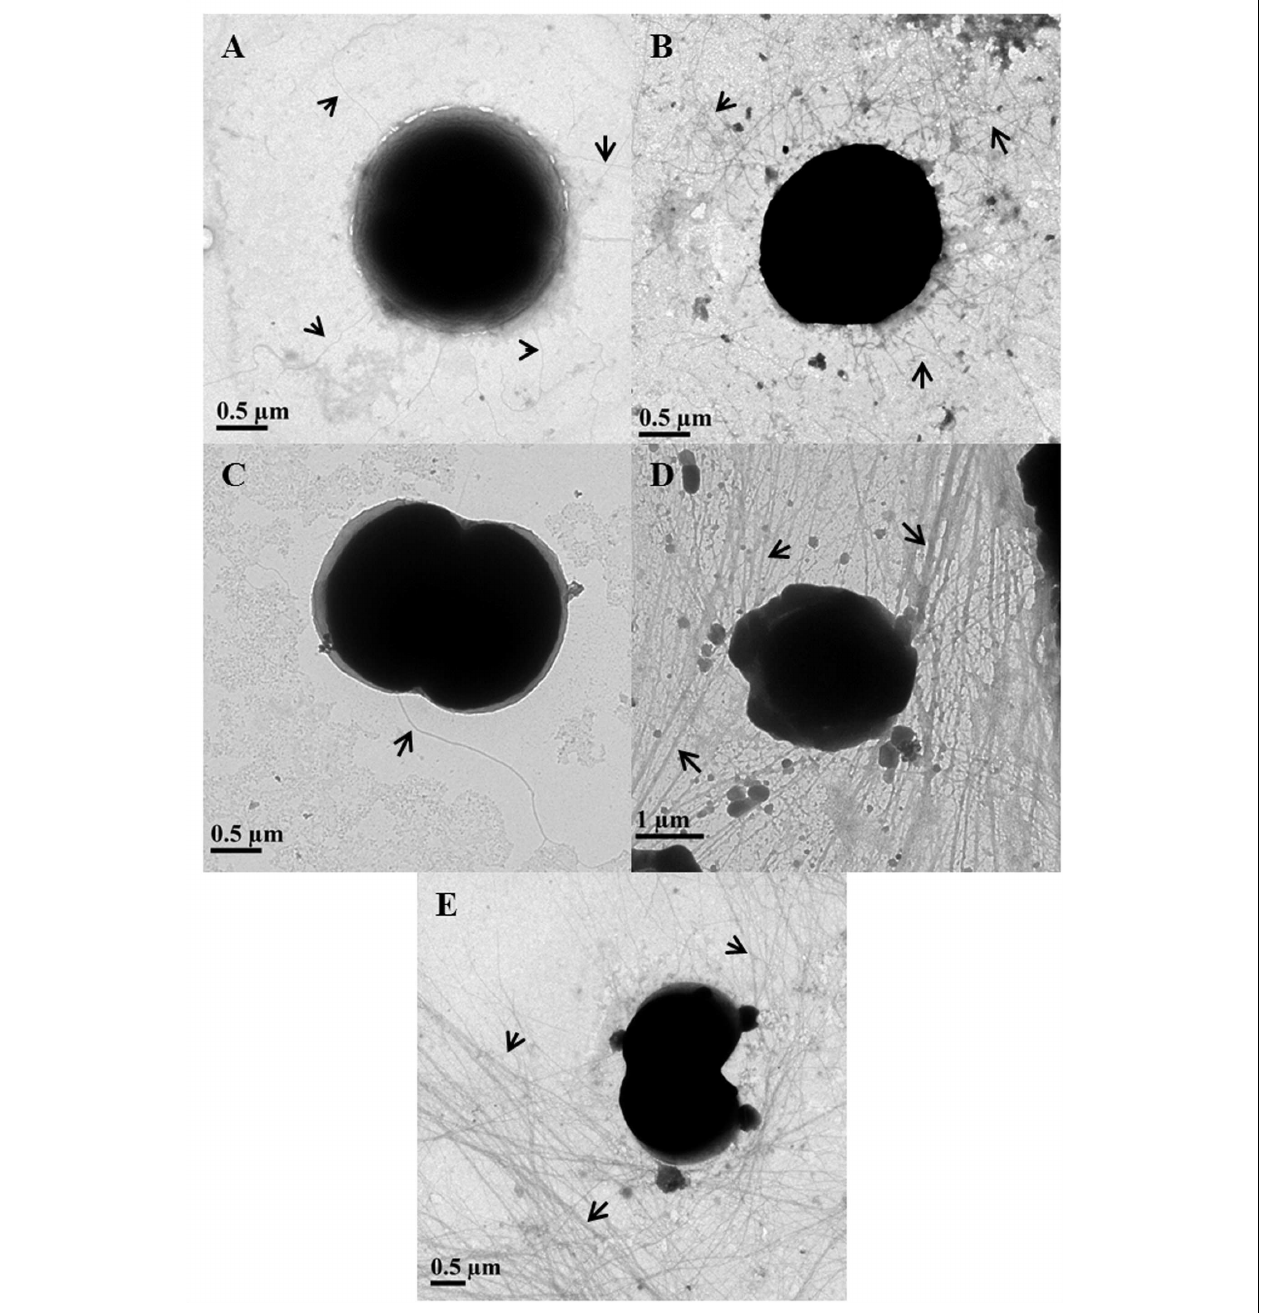
FIGURE 3 | Determination of piliation level in arsenic treated Synechocystis cells using transmission electron microscopy. Control (A) and 75 mM As (V) (B) treated cells showed similar level of piliation while very few to almost no pili were observed in 300 mM As (V) treated cells (C) . Longer and high number of pili observed in cells treated with 1 mM (D) and 4 mM (E) concentration of As (III). Pili have been shown with black